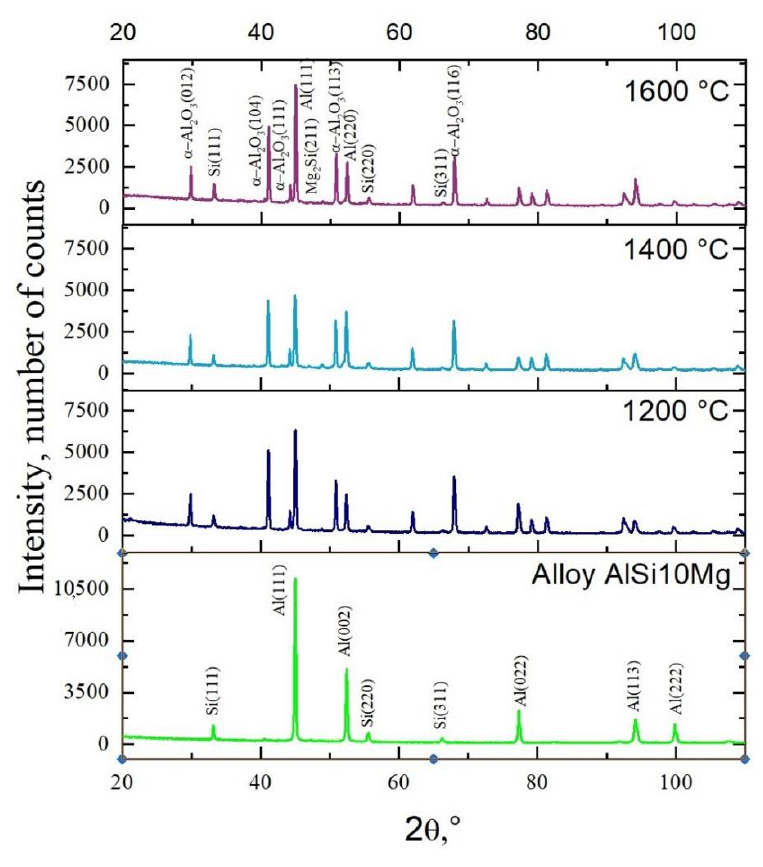
Figure 5. X-ray diffraction analysis results.